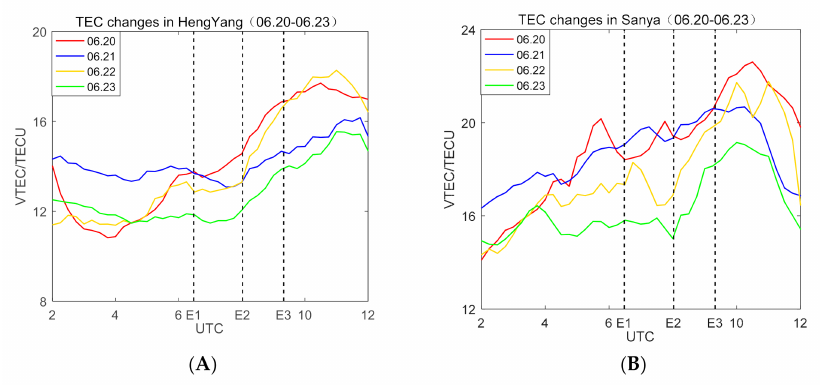
Figure 11. ( A ) The change of Ionospheric Total Electron Content (TEC) from 20 June 2020 to 23 June 2020 in Hengyang, Hunan Province, and ( B ) is TEC change in Sanya, Hainan Province.